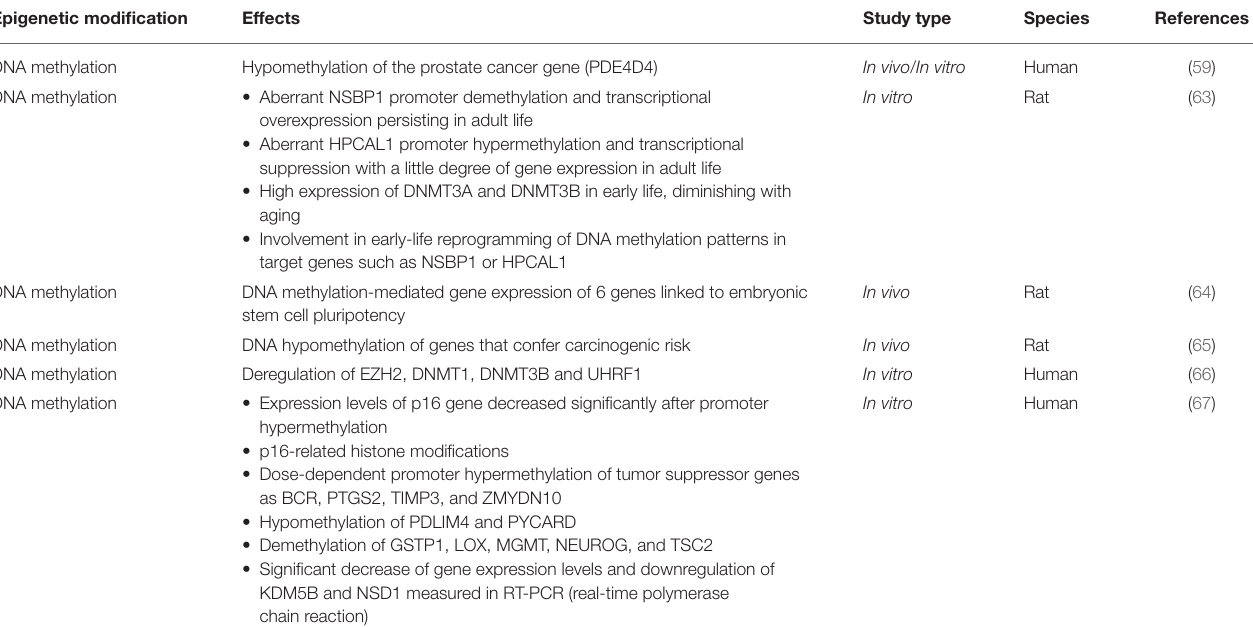
TABLE 6 | Characteristics of the studies which analyzed the risk of prostate cancer induced by BPA